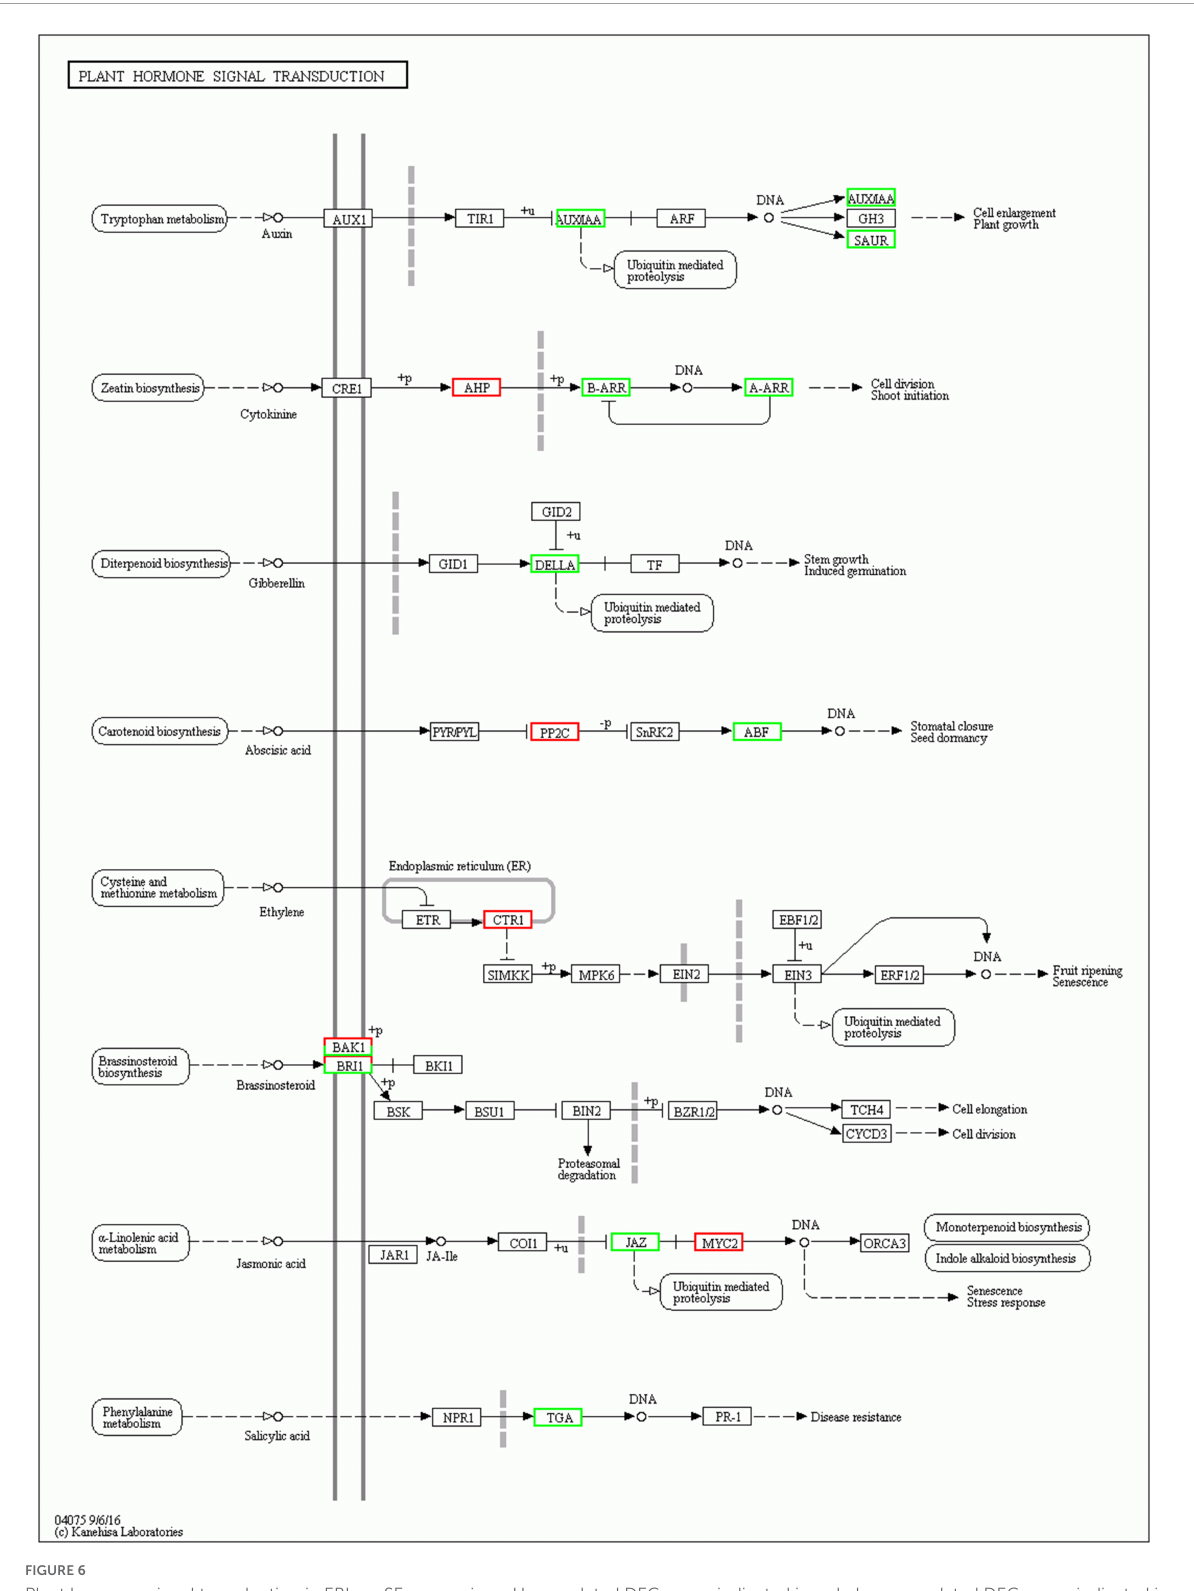
FIGURE6 Plant hormone signal transduction in EBL vs. SE comparison. Up-regulated DEGs were indicated in red, down-regulated DEGs were indicated in green.